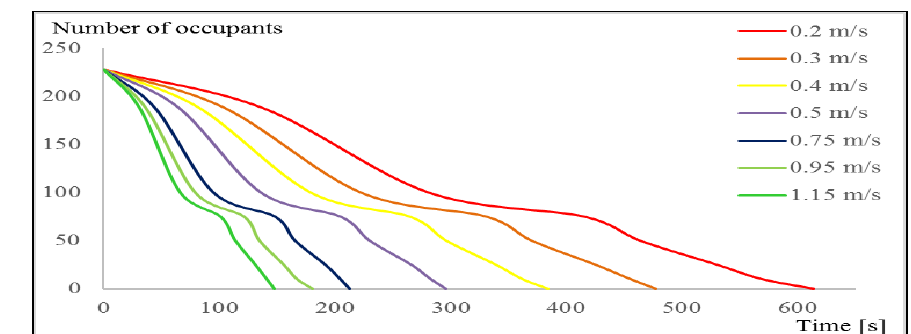
Figure 8 – Simulation results for the first case of the first scenario Рис. 8 – Результаты моделирования первого случая по первому сценарию Слика 8 – Симулациони резултати за први случај првог сценарија